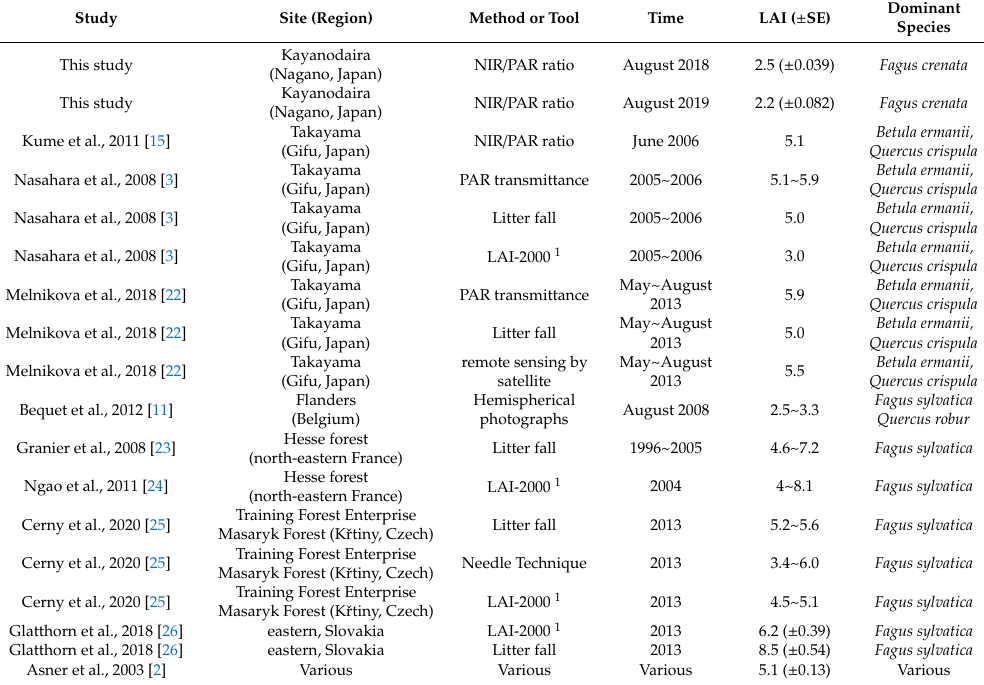
Table 3. LAI value of some deciduous broadleaf